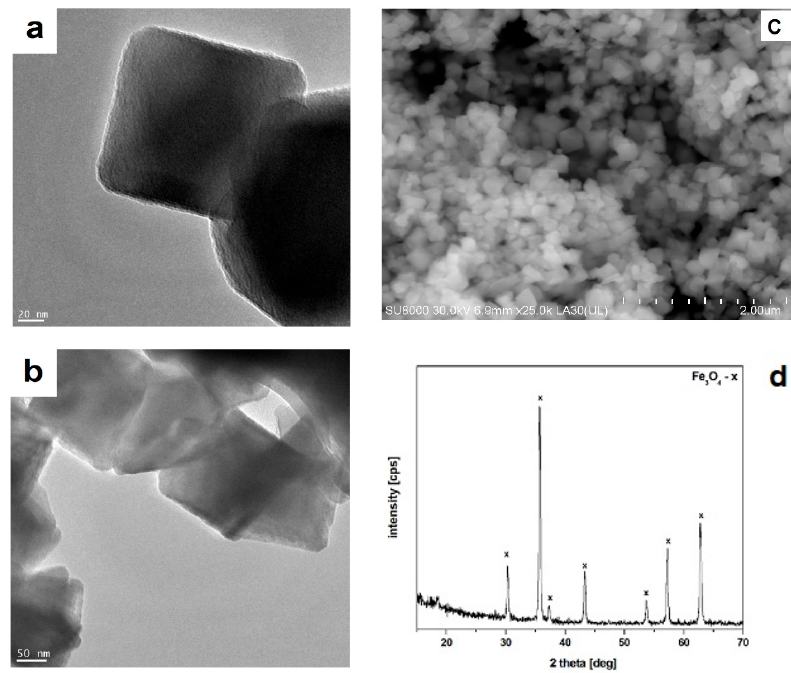
Figure 1. ( a , b ) a transmission electron microscopy (TEM) micrograph, ( c ) a scanning electron microscopy (SEM) micrograph, and ( d ) the X-ray diffraction (XRD) pattern of nano-Fe 3 O 4